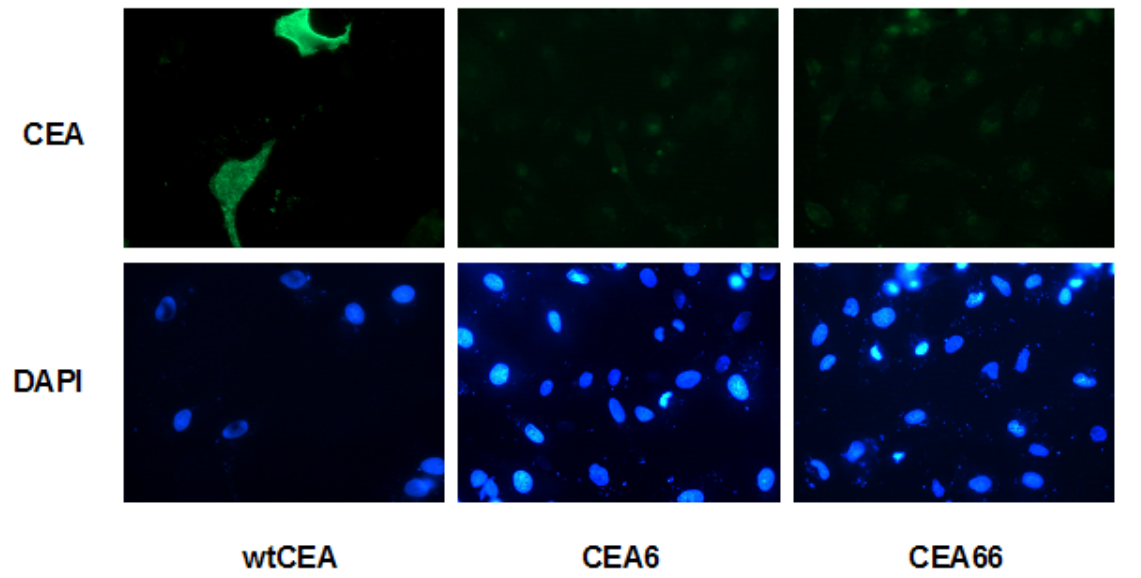
FIGURE 3. Signal sequence deletion prevents CEA transport to the cell surface. HeLa cells were transfected with wt CEA p91023(B), pKCEA6, or pKCEA66, and stained with rabbit antihuman CEA 48 h post-transfection. Counterstaining with DAPI was performed to indicate cell